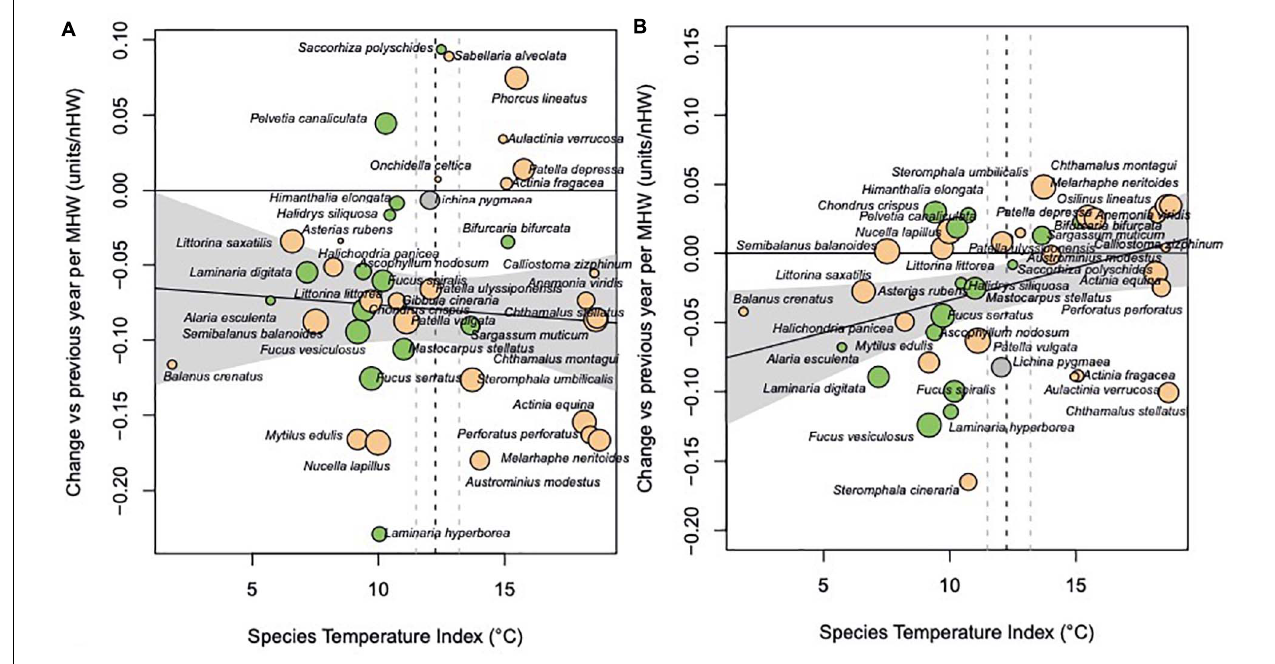
FIGURE 4 | (A) Response to summer heatwaves, shown as the trend in annual abundance change relative to annual frequency of heatwaves. (B) Response to winter heatwaves. Regression slopes for (A) Y = –0.064 ( ± 0.035 SE) – 0.0012.STI ( ± 0.0027 SE), p = 0.65; (B) Y = –0.081 ( ± 0.026 SE) + 0.0047.STI ( ± 0.0021 SE), p = 0.028.